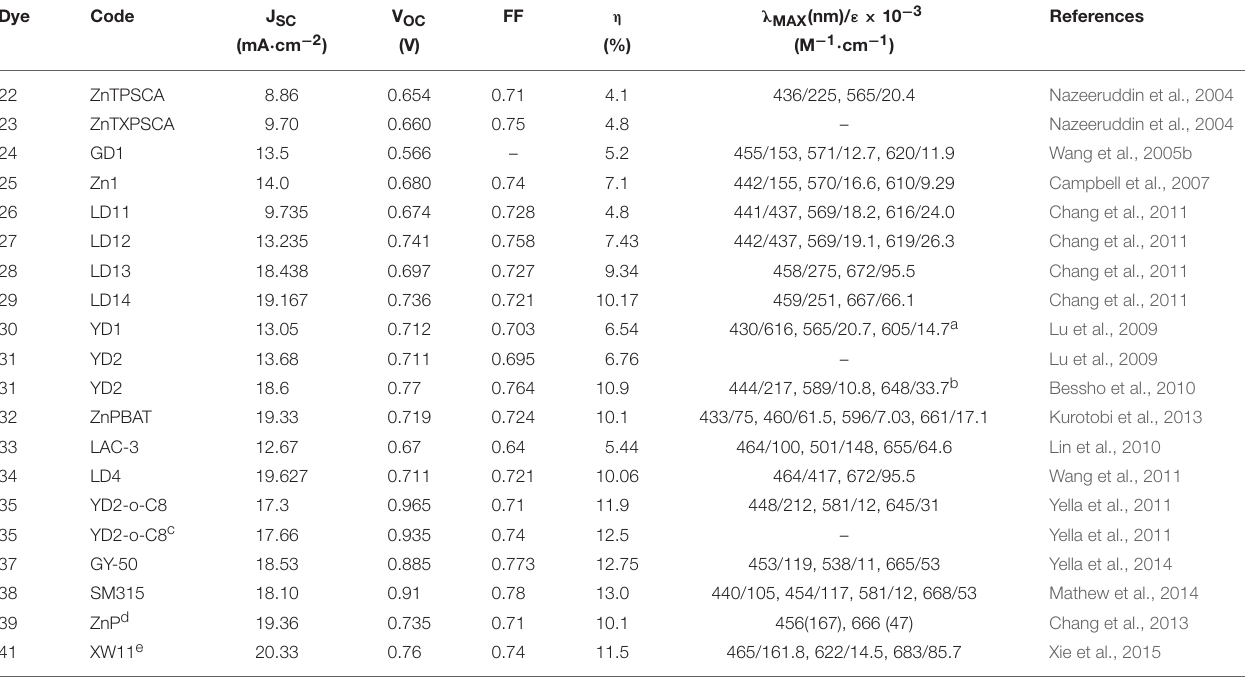
TABLE 2 | Photovoltaics parameters of DSSC sensitized with porphyrin-based sensitizers 22–41.